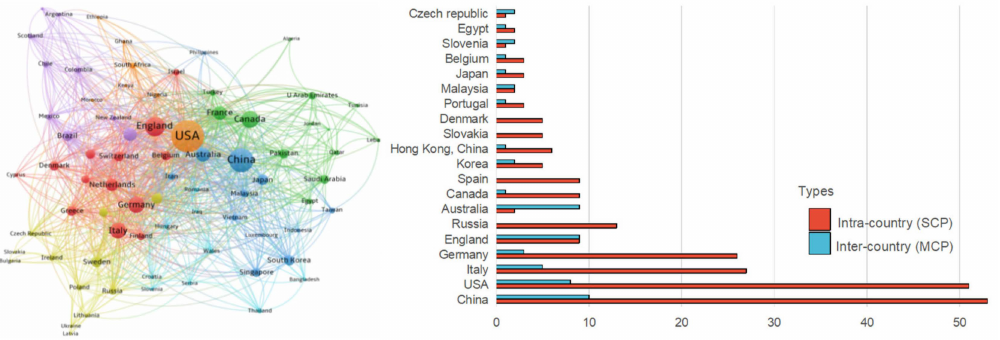
Figure 5. Collaboration of Countries. Intra-country (SCP) and Inter-country (MCP) Collaboration of Top 20 Countries or